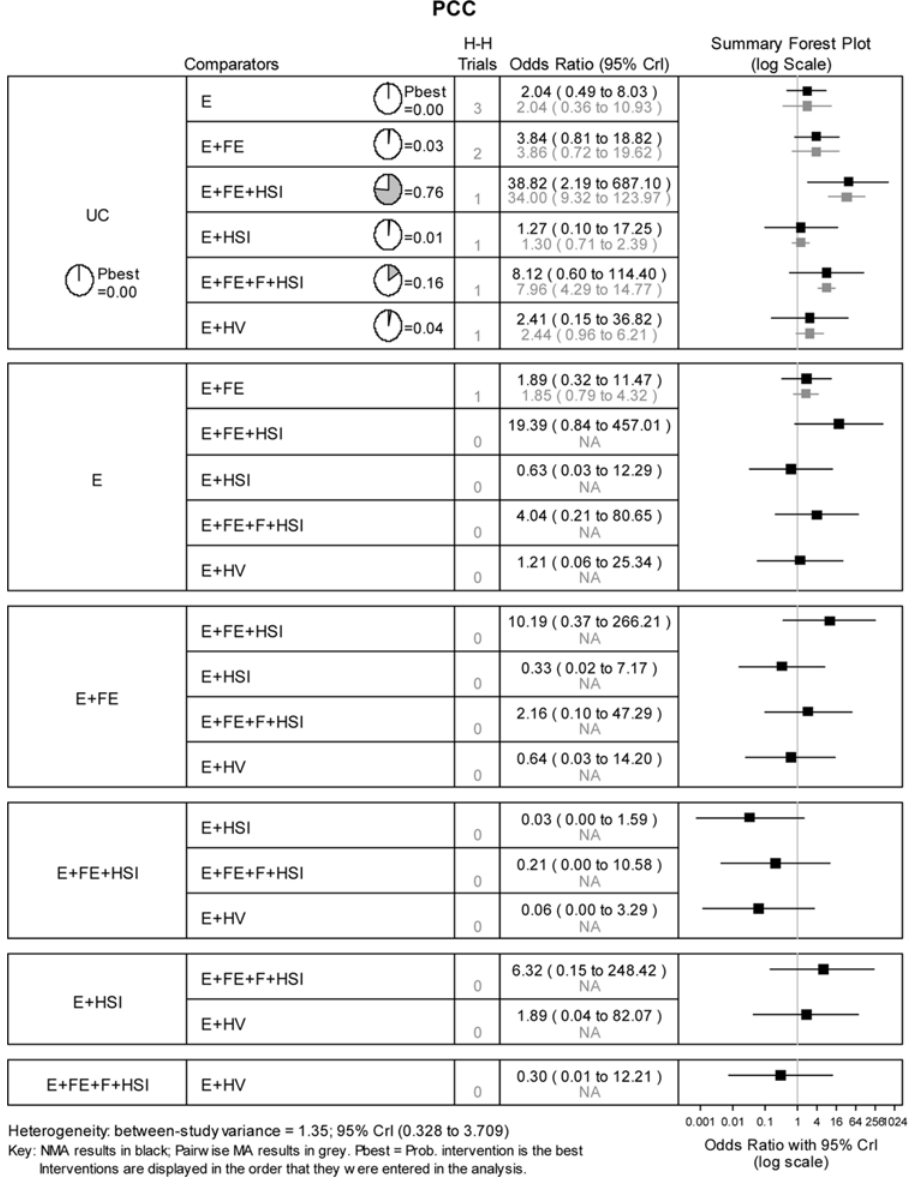
Fig 7. Network meta-analysis results for possession of poison control centre number. H-H trials refer to the number of head-to-head trials available for the specified pairwise